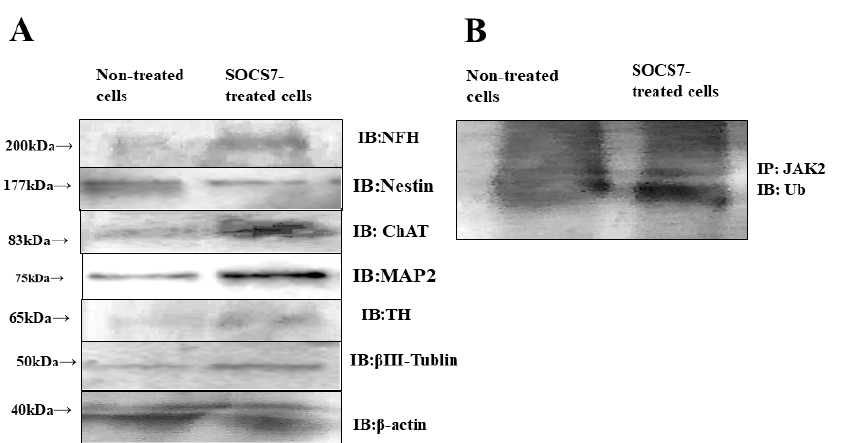
Figure 5. Immunoblotting (IB) and immunoprecipitation (IP) study on SOCS7-peptide-treated and non-treated cells. ( A ) Immunoblotting was done with anti-neurofilament-H (NFH), choline acetyl transferase (ChAT), nestin, choline acetylcholine transferase (ChAT), microtubule-associated protein 2 (MAP2), tyrosine hydroxylase (TH), and β III-Tublin antibodies, anti-NFH antibody, anti-ChAT antibody, anti-TH antibody, and anti-actin antibody as an internal control. ( B ) Immunopre- cipitation with anti-JAK2 antibody was followed by immunoblotting with anti-ubiquitin antibody.